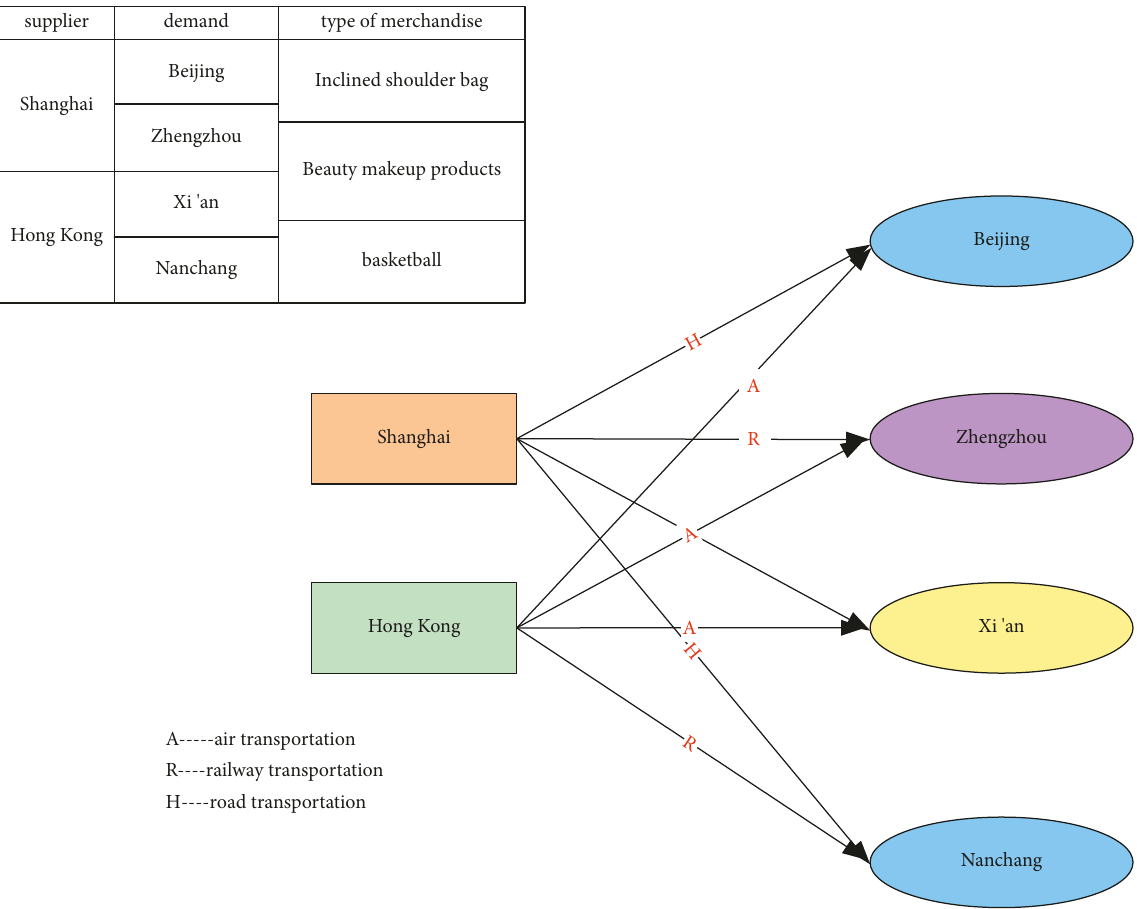
Figure 4: Multimodal transport with multiple types and